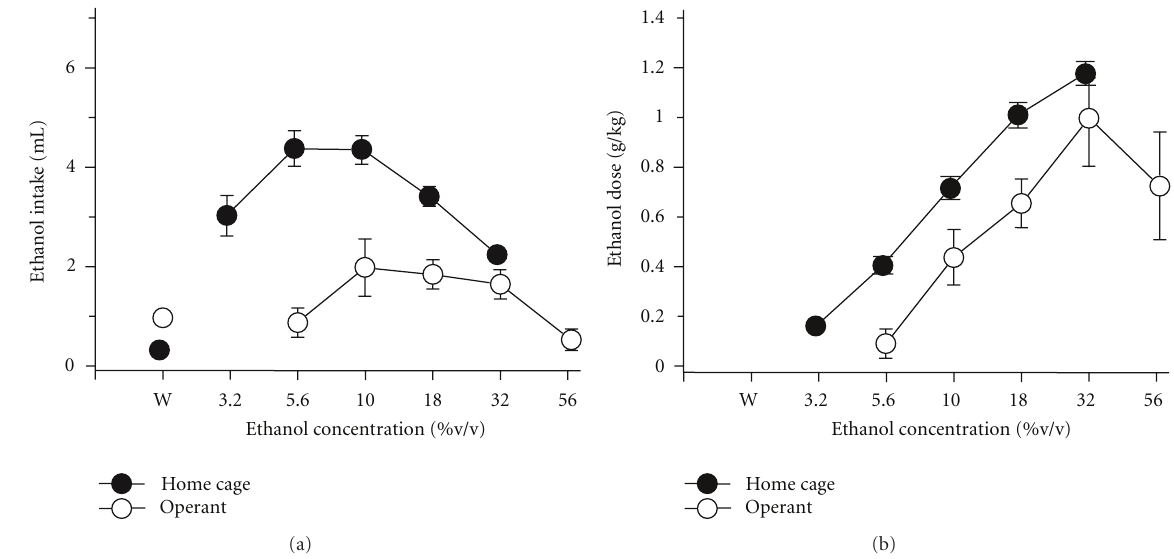
Figure 4: E ff ects of ethanol concentration on ethanol intake (mL) and the dose of ethanol (g/kg) consumed under home cage ( n = 22) and operant ( n = 5) self-administration procedures. Filled circles represent voluntary home cage ethanol intake, whereas unfilled circles represent operant ethanol intake under a fixed ratio (FR) 10 schedule of reinforcement. The points and vertical lines above “W” indicate the means ± standard error of the mean (SEM) for sessions in which water was available (control). The points with vertical lines in the concentration-e ff ect data indicate the mean ± SEM for each ethanol concentration. The points without vertical lines indicate instances in which the SEM is encompassed by the point.